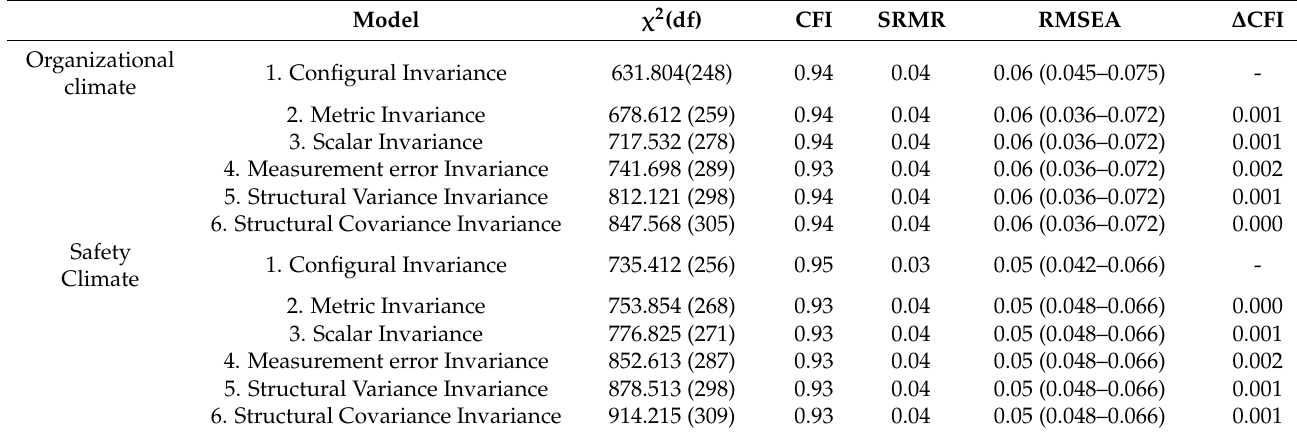
Table 3. Fit statistics for measurement invariance by